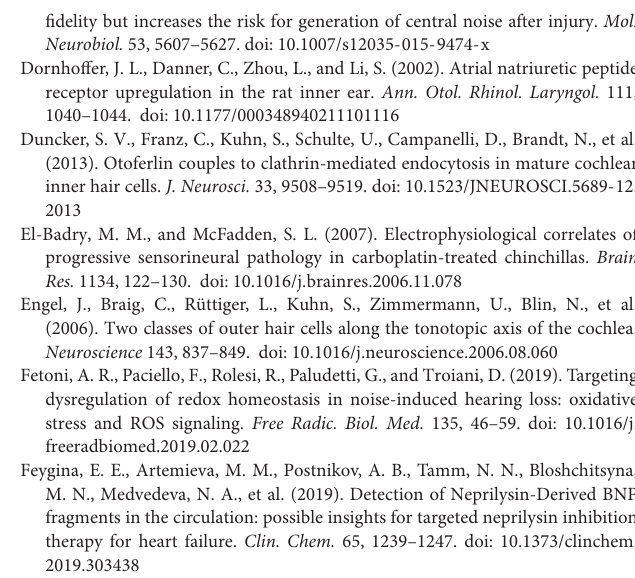
FIGURE S1 | Slopes of growth functions of DPOAE signals and regressions on DPOAEs loss in GC-A WT and GC-A KO mice. (A) Shifts of DPOAE signal growth functions in response to pure-tone sounds at f1 = 5.6 kHz (left panel) were similar between GC-A KO and WT mice [two-way ANOVA, F (1,121) = 0.03, P = 0.8693, WT n = 3/6 mice/ears KO n = 4/7 mice/ears], while GC-A KO mice had smaller shifts after acoustic trauma for pure-tone sounds with f1 = 11.3 kHz [middle panel, two-way ANOVA, F (1,180) = 6.06, P = 0.0148, WT n = 3/6 mice/ears KO n = 4/8 mice/ears]. (B) To normalize the DPOAE I/O shift for respective frequencies, and to account for genotype differences preceding acoustic trauma induction, the regression between the measured DPOAE signal (in dB SPL) after acoustic trauma and the loss of DPOAE signal (in dB SPL) was calculated. The regression lines were not different between GC-A WT and KO mice with f1 = 5.6 kHz [left panel: unpaired two-tailed student’s t -test t (183) = 0.226, P = 0.98, WT n = 85 KO n = 102] and 11.3 kHz [middle panel: unpaired